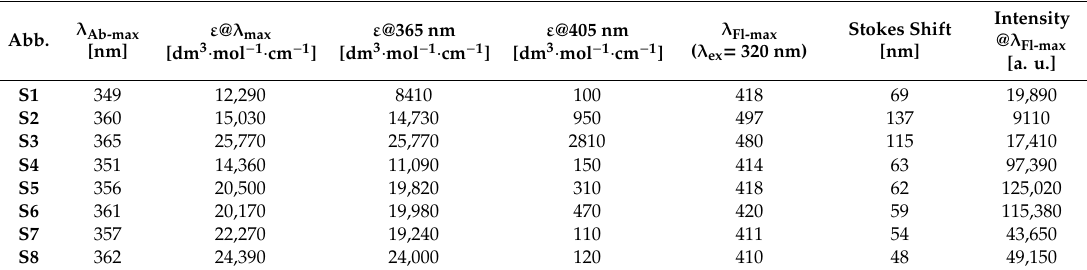
Table 1. Light absorption and fluorescence data of investigated compounds in acetonitrile: maximum absorption wavelengths ( λ Ab-max ), molar extinction coe ffi cients ( ε ) at λ Ab-max , and, at the emission wavelengths of the LEDs, maximum emission wavelengths ( λ Fl-max ), Stokes